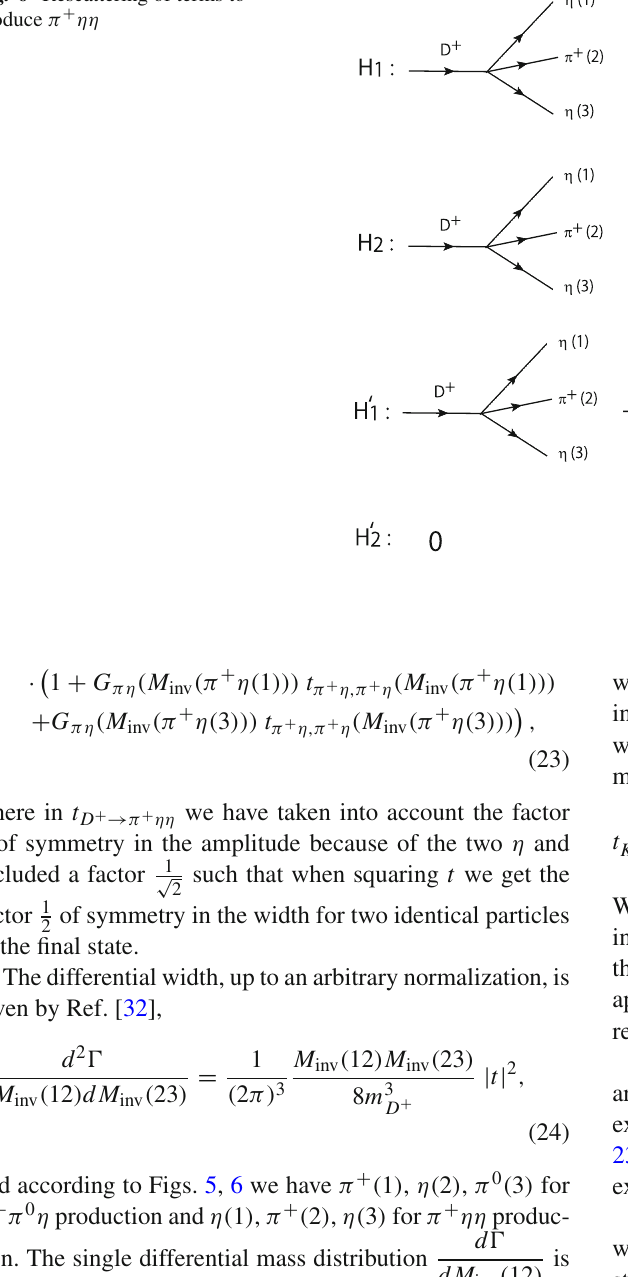
Fig. 6 Rescattering of terms to produce π +